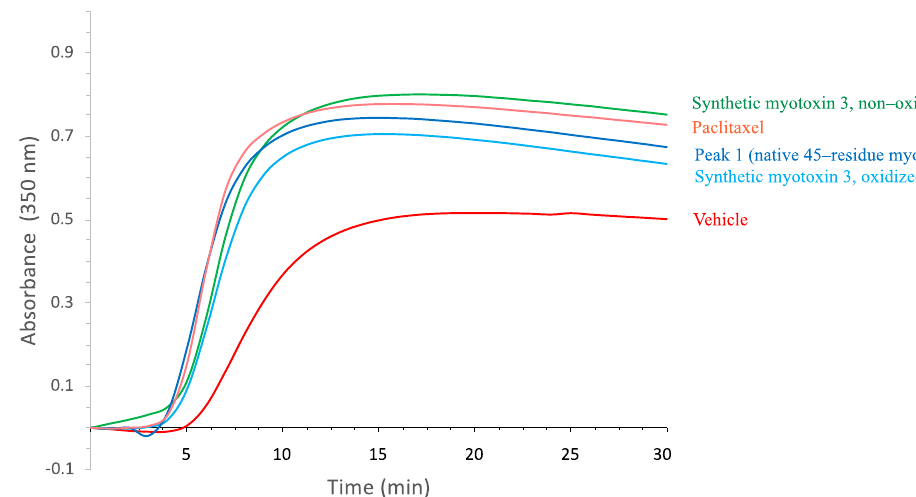
Figure 5. Tubulin polymerization in the presence of myotoxin-3. Tubulin polymerization assay was performed in the absence (vehicle, red line) or in the presence of 15 µM myotoxin-3, either native (peak 1) or synthetic (oxidized and non-oxidized forms). Paclitaxel (15 µM) was used as a positive control. The increase in the turbidity at 350 nm is proportional to tubulin polymerization. The data shown are from a representative experiment of two performed.